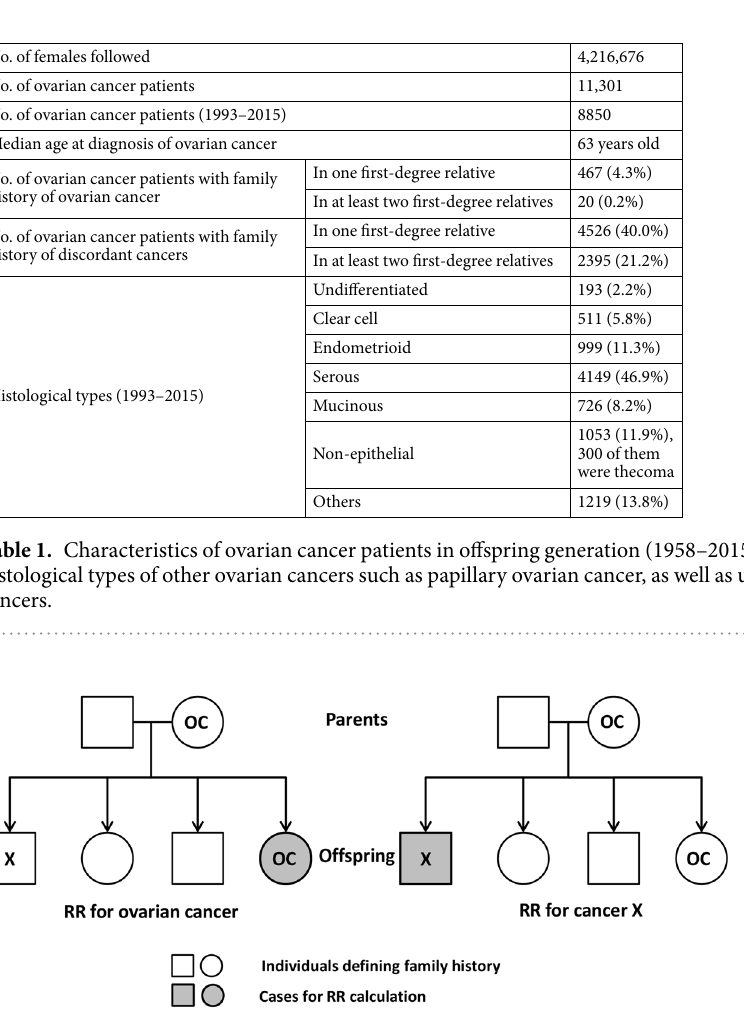
Figure 1. Flowchart of calculating the RRs for ovarian cancer and cancer X in a two-way analysis. On the left side, RR was calculated for ovarian cancer when family history was cancer X; person-years at risk were calculated for all offspring; probands were all first-degree relatives. On the right side, RR was calculated for cancer X when family history was ovarian cancer. OC: ovarian